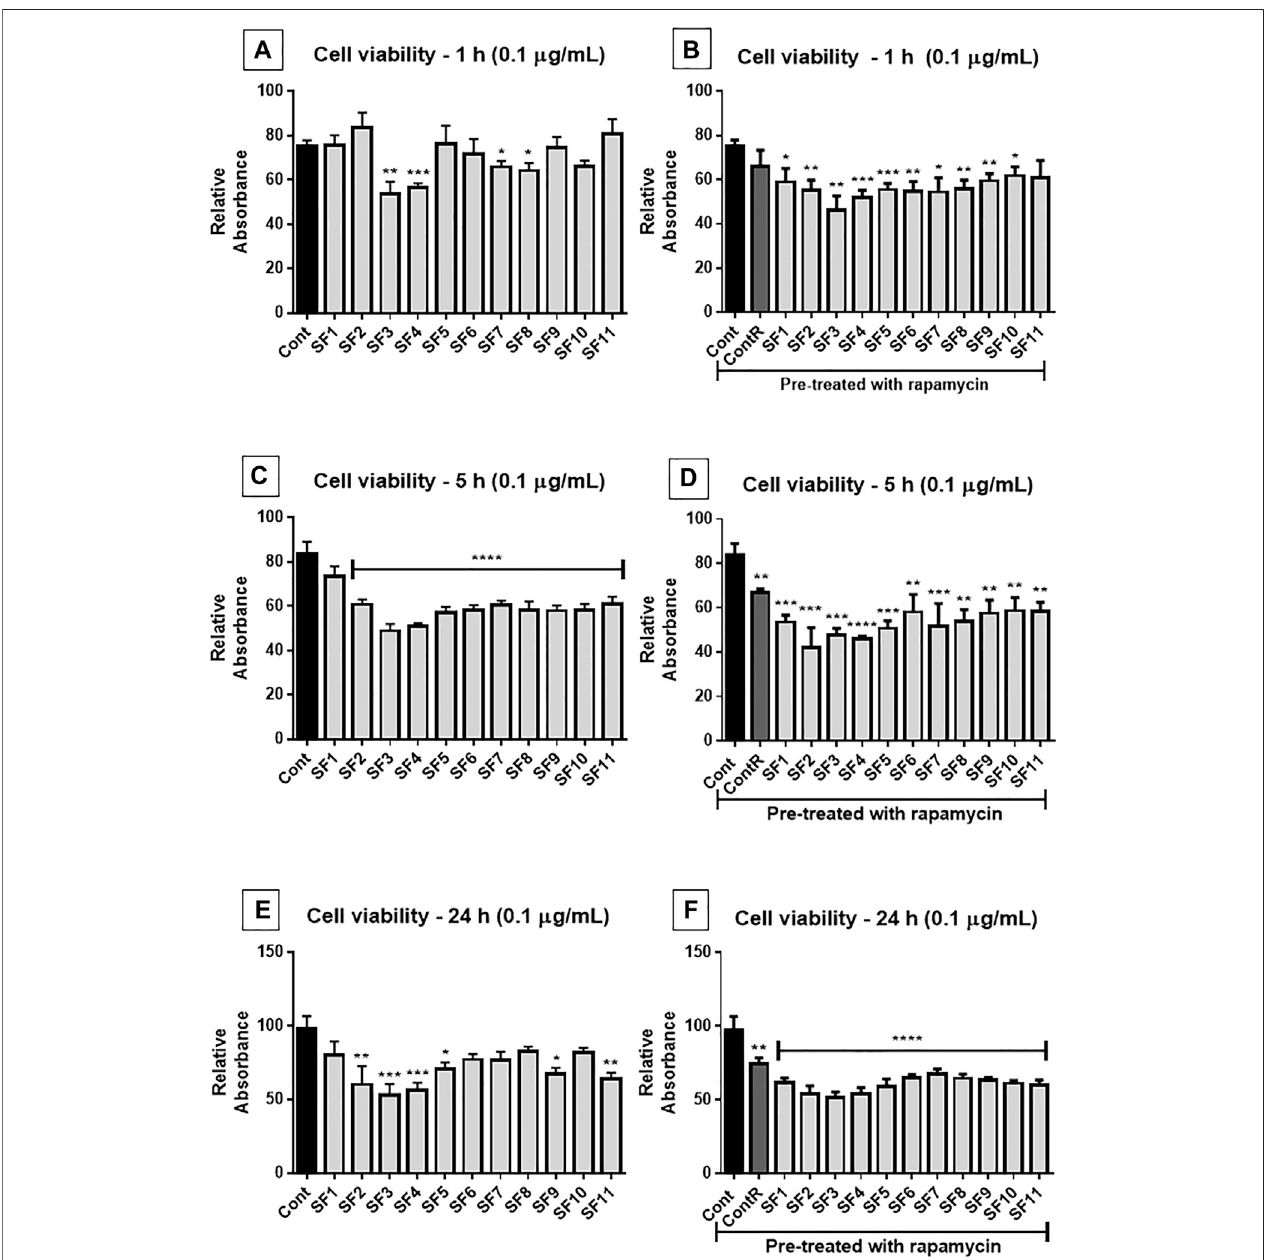
FIGURE6| Cellviabilityassay(MTT):humanGBcellstreatedwithsubfractions(SF1toSF11)at0.1 μ g/ml,withorwithoutmTORinhibitionwithrapamycin. (A) After 1 h of exposure, SF3, SF4, SF7, and SF8 signi fi cantly reduced the viability of GB cells, compared to the untreated control. (B) Once the cells were pretreated with rapamycin, all SFs signi fi cantly reduced cell viability (except SF11). (C) 5 h after exposure, all SFs signi fi cantly reduced cell viability. (D) All SFs also reduced cell viability whenthey werepretreated withrapamycin. (E) After24 hoftreatment,SF2, SF3, SF4,SF5, SF9,and SF11signi fi cantlyreducedcellviability,and whenpretreated with mTOR inhibitor, all SFs decreased viability of GB cells. (F) ANOVA followed by Dunnett ’ s multiple comparisons test; unpaired Student ’ s t-tests were used to compare each treatment with the control. * p < 0.05, ** p < 0.01, *** p < 0.001, **** p < 0.0001, compared to the control (Cont).